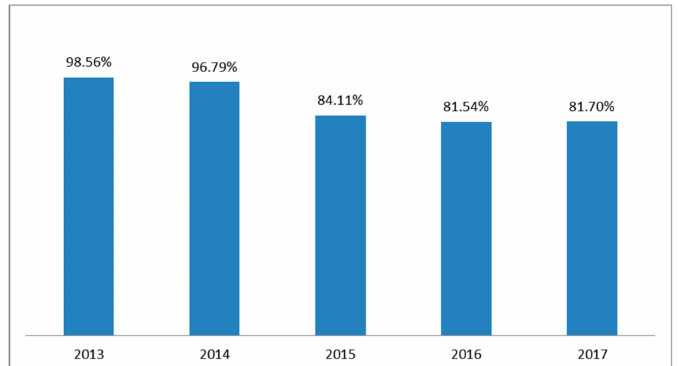
Figure 5. The level of availability of EE infrastructure. Source: Authors’ calculation (based on data from Figure